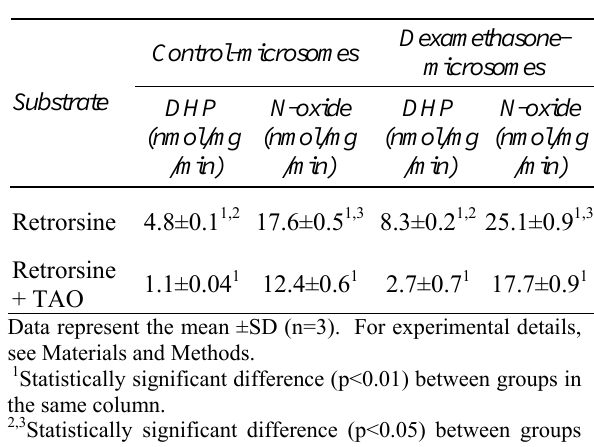
Table 1: Quantification of DHP and PA N -oxide formation in an in vitro PA metabolism by rat liver microsomes